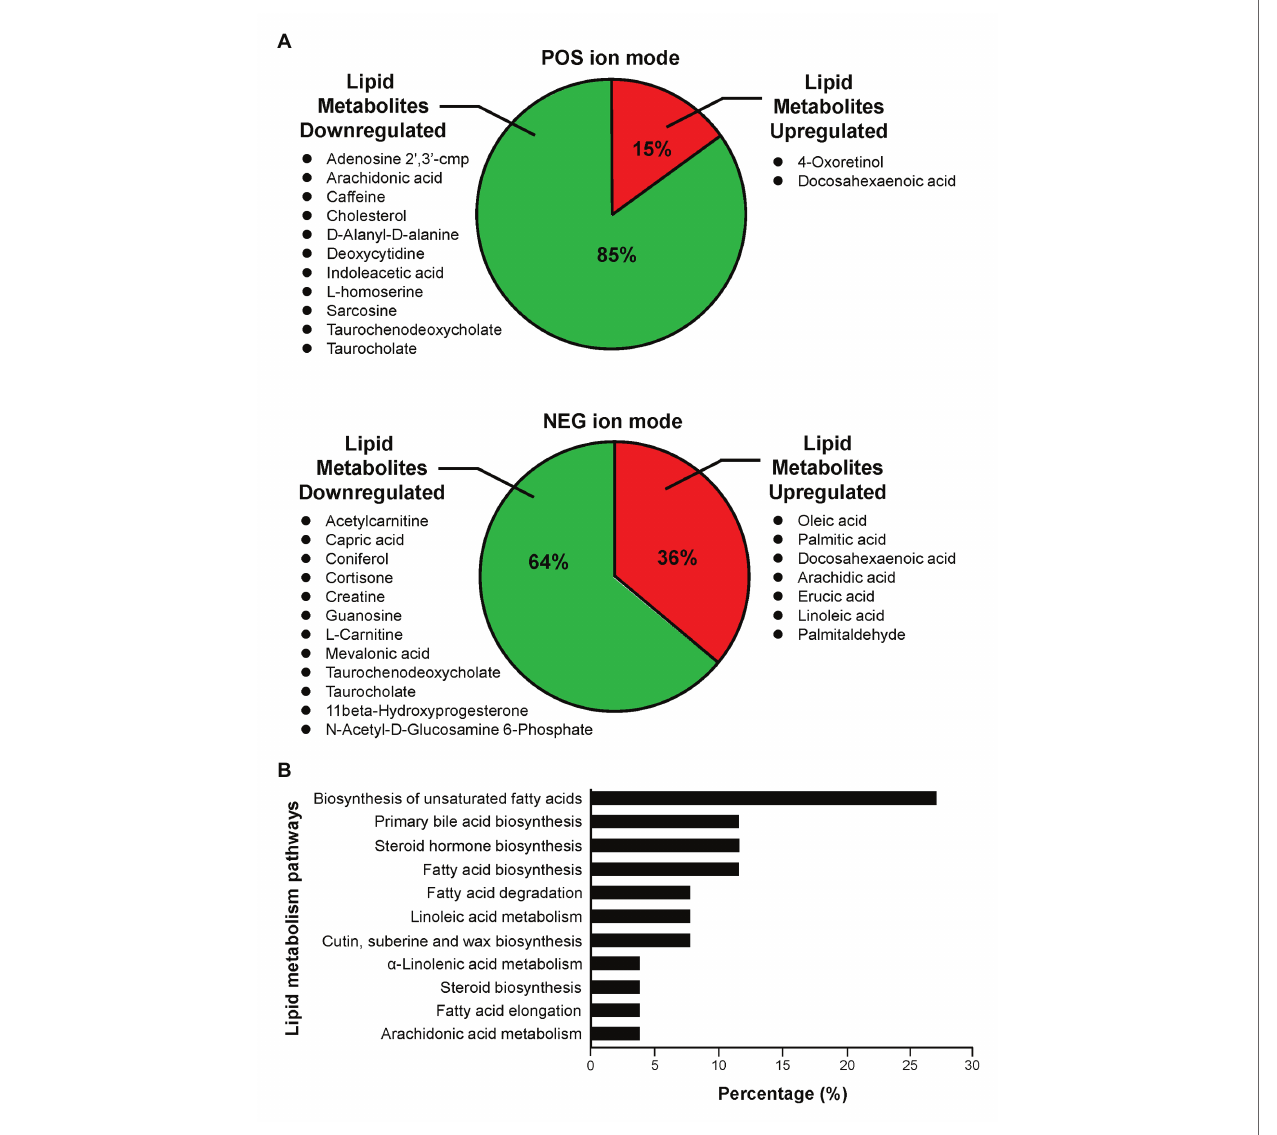
FIGURE 3 | Functional classification of DEMs according to their corresponding pathways. (A) Proportion of upregulated and downregulated metabolites associated with lipid metabolism of 5HP-infected shrimps in POS and NEG ion modes. (B) KEGG pathway breakdown of the lipid metabolism DEMs. Metabolites without MS/ MS annotations were